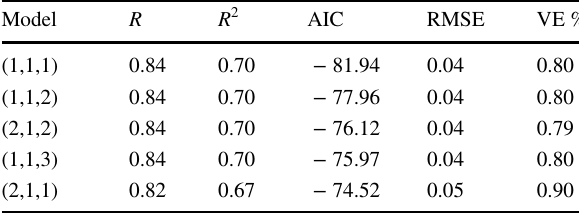
Table 4 The consequences of Cl − group, order (1, 2)